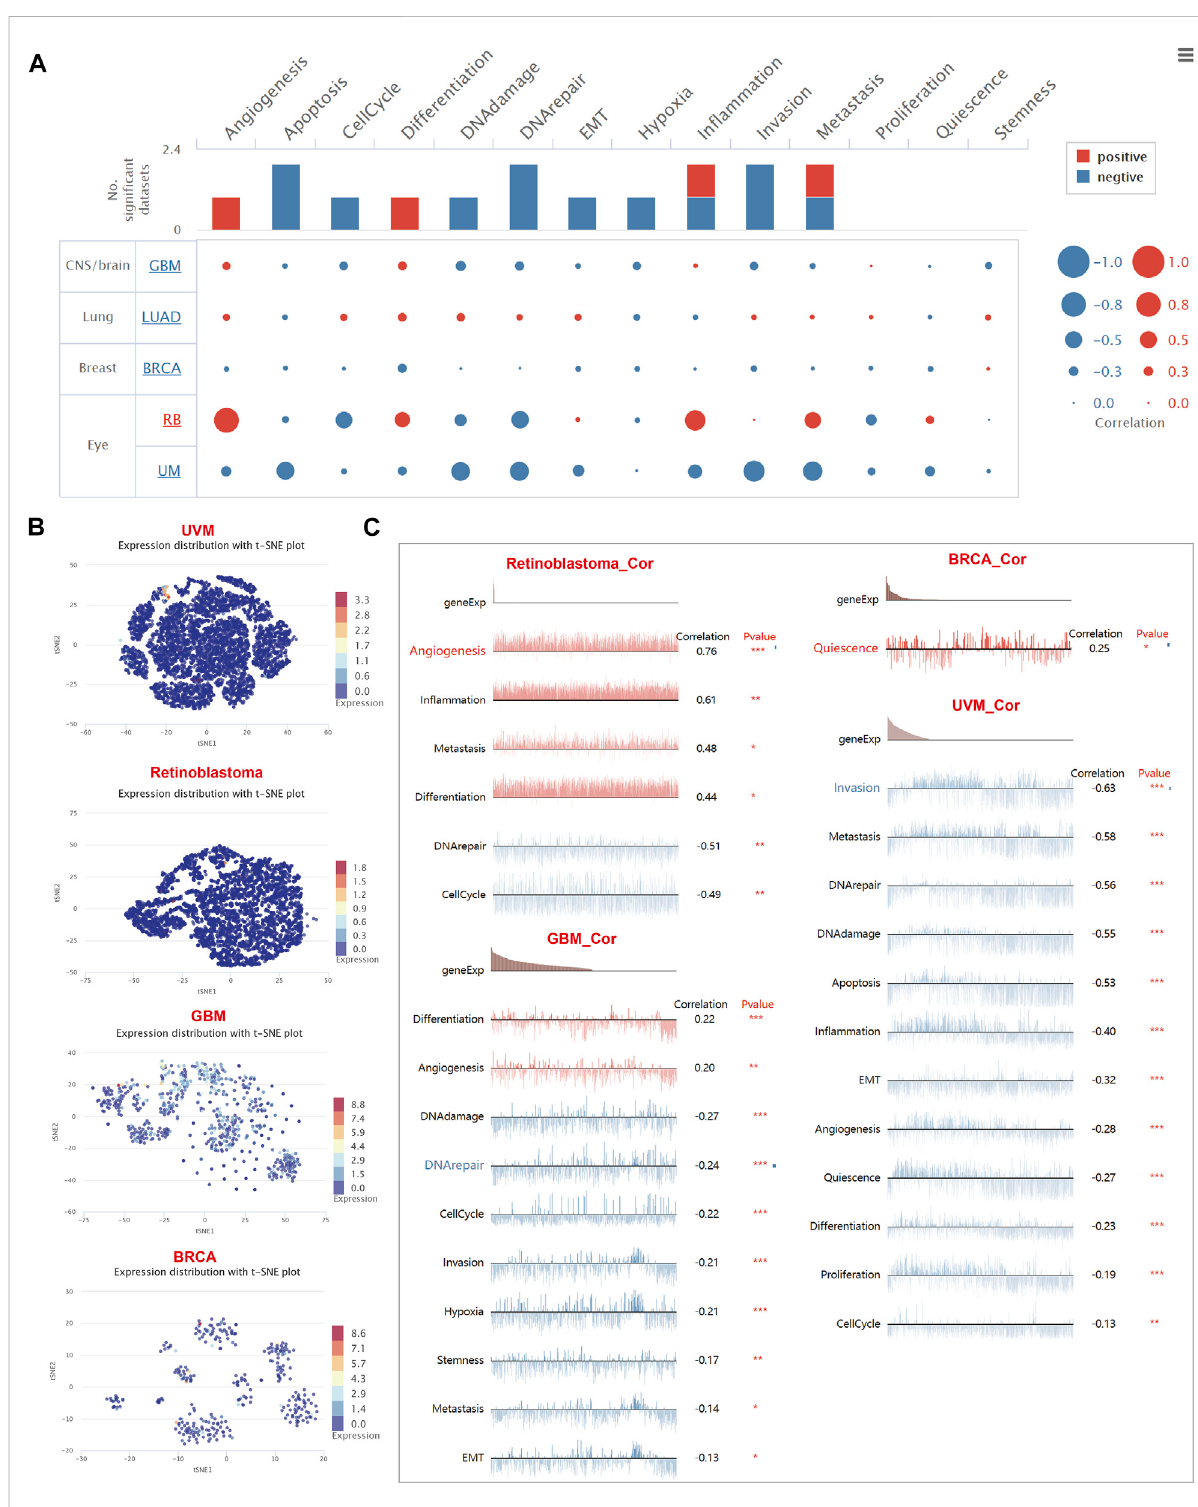
FIGURE 8 The role of CD8A and its functional relevance across varying cancer types at single-cell resolution (A) Correlations between CD8A and functional relevance of varying cancer types, with size of the bubble indicating strength of correlation, and bar plots showing datasets number in which CD8A signi fi cantly related to the corresponding state (B) Single-cell clustering visualization using tSNE disclosed the heterogeneity in the expression levels of CD8A in various cell clusters (C) Correlation between CD8A expression, and functional states in distinct